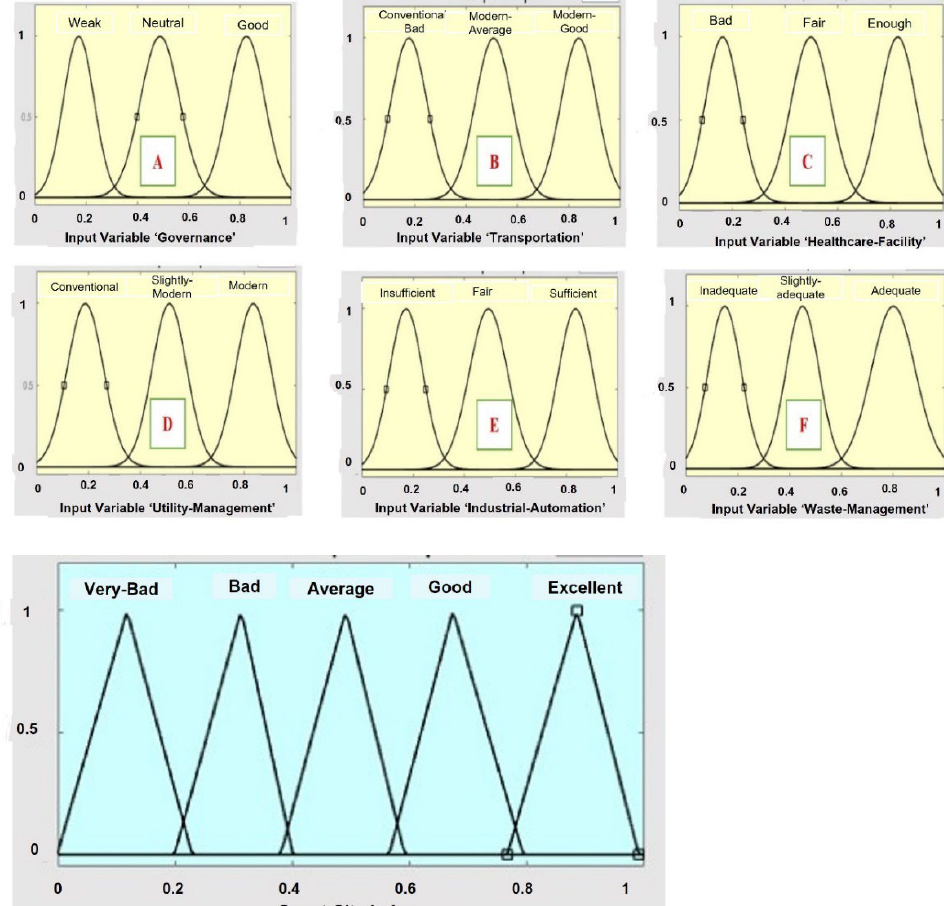
Figure 5. Fuzzy input and output variables with membership functions.